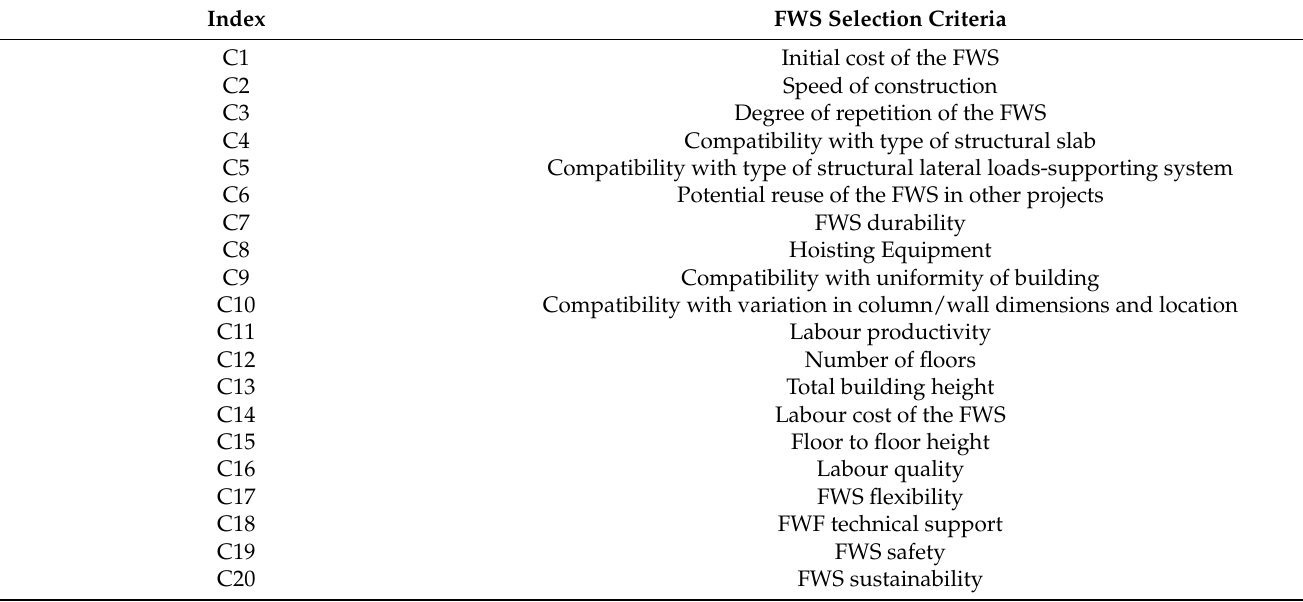
Table 3. FWS selection criteria determined by the decision-making team for the case